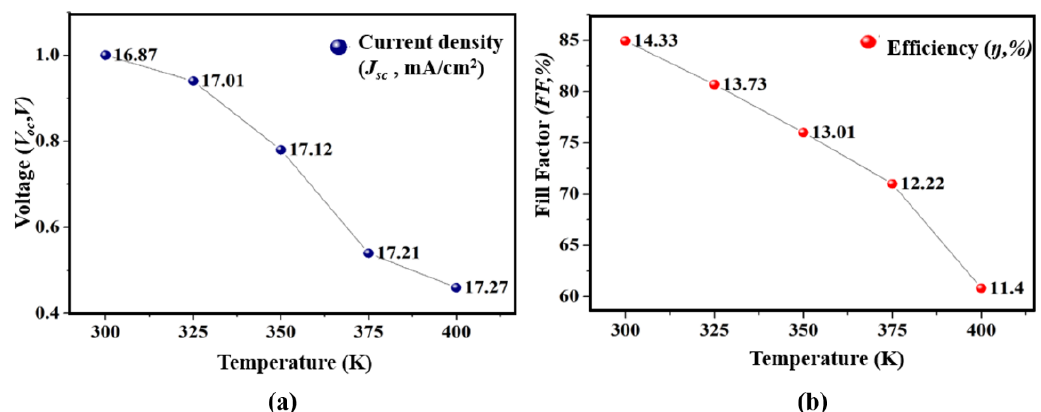
Figure 8. Influence of temperature on photovoltaic parameters. ( a ) V oc and J sc ; ( b ) FF and η